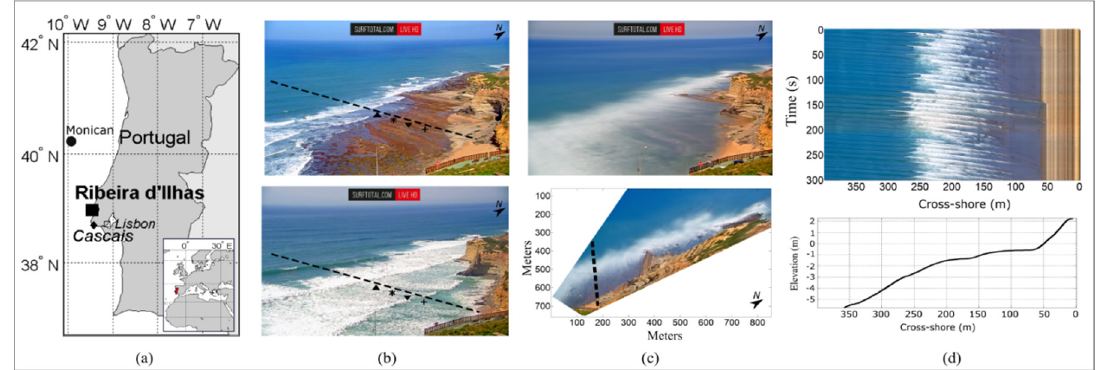
Figure 1. Study site and video data. ( a ) Geographic location of Ribeira d’Ilhas beach (black square), Monican buoy (circle), and Cascais tide gauge (diamond). ( b ) The 10-min Timex images produced during low tide (top) and high tide (bottom). Symbols show pressure transducers array in the intertidal area, dashed black line represents the transect used to produced Timestack images. ( c ) Examples of oblique (top) and rectified (bottom) Timex. Dashed black line represents the transect used to produced Timestack images. ( d ) Timestack image example (top) and corresponding beach profile (bottom). The profile also corresponds to the transect sampled on Timex to retrieve I TX .